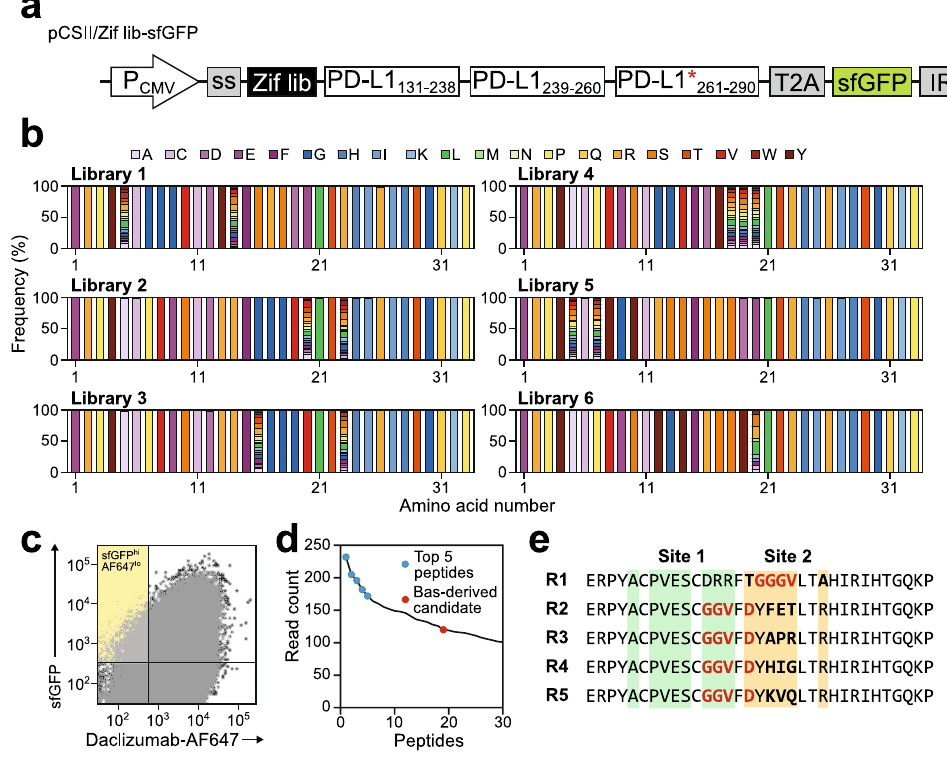
Figure 4. Antibody-guided screening for Zif-FLAP candidates. ( a ) Diagram of the Zif-FLAP candidate library construct. Zif lib, Zif-FLAP candidate peptide library. ( b ) Amino acid frequency in each library set prior to screening. ( c ) Isolation of the high sfGFP, low AF647 fraction after flow cytometric analysis. K562/CD25 cells transduced with the library construct were incubated with daclizumab-AF647 and then analyzed by flow cytometry for sfGFP expression and AF647 signals. The quadrant in yellow represents the fraction that was sorted out for sequencing. ( d ) Ranking of peptides in accordance with the read count after NGS analysis. The five most frequently detected sequences are shown by blue circles. The basiliximab (Bas)-derived sequence is indicated by a red circle. ( e ) Sequences of the top five peptides with the highest read counts. Residues that had been mutated are shown in bold with residues in black representing those that had been fully randomized and those in red representing the CD25-binding residues identified from